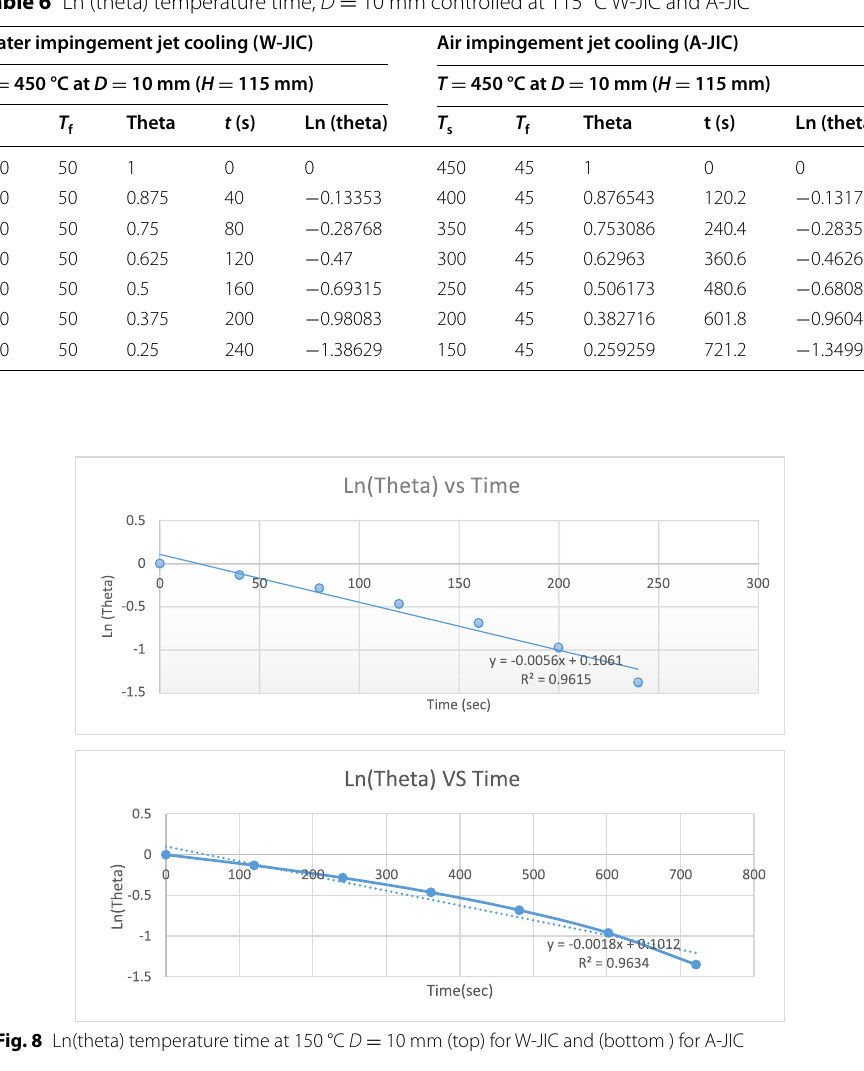
10 mm (top) for W-JIC and (bottom ) for =